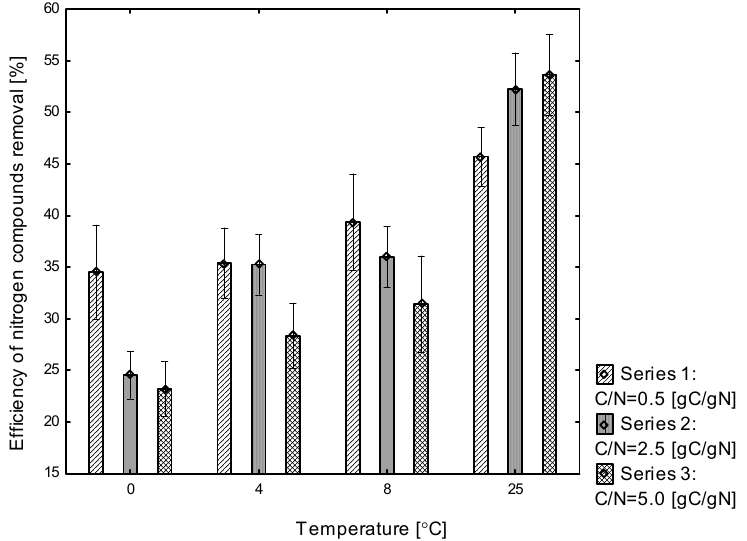
Figure 6. Temperature influence on the efficiency of nitrogen compound removal, depending on the C/N ratio.